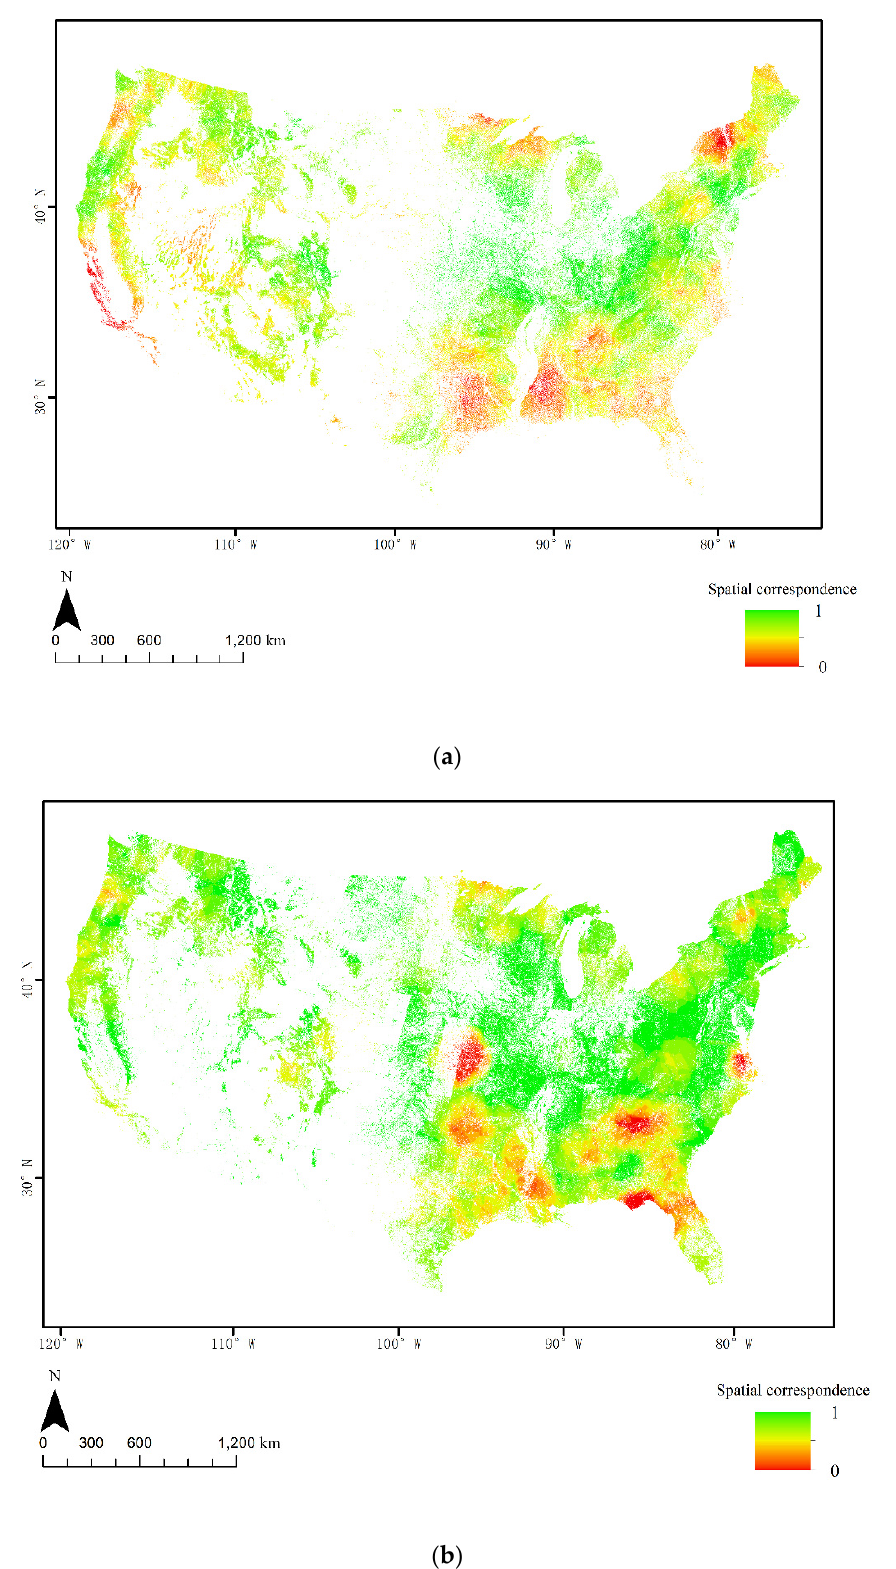
Figure 9. Local accuracy probability results: ( a ) NLCD2011; ( b ) FROM-GLC-Seg.